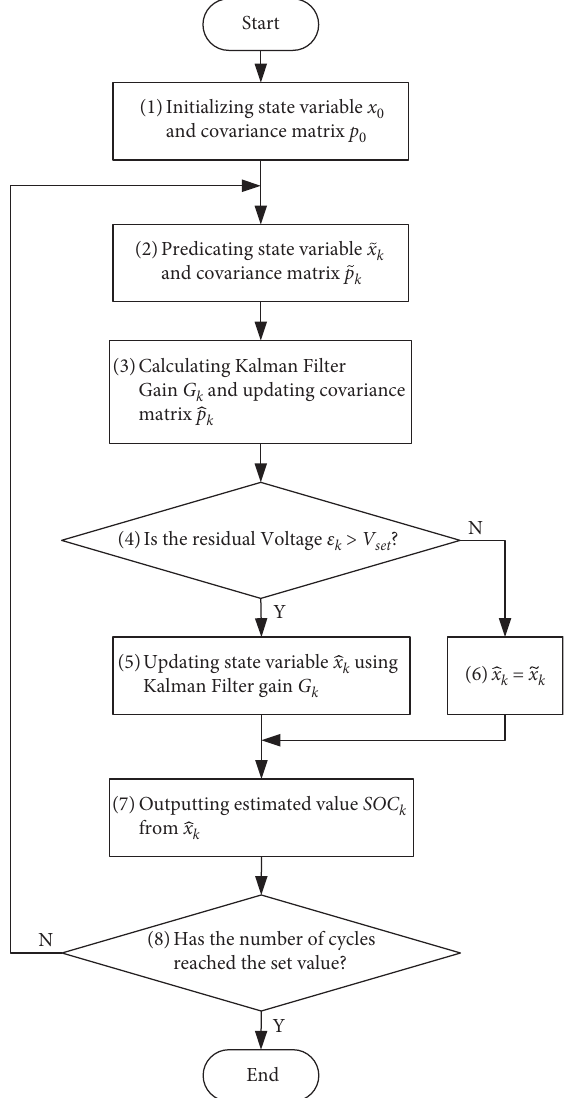
Figure 3: Flowchart of SOC estimation using